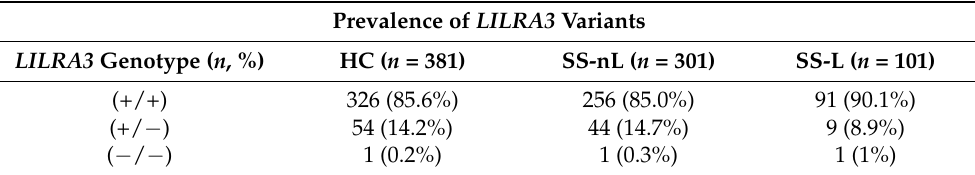
Table 1. Frequency of LILRA3 genotypes in distinct SS subpopulations and HC.